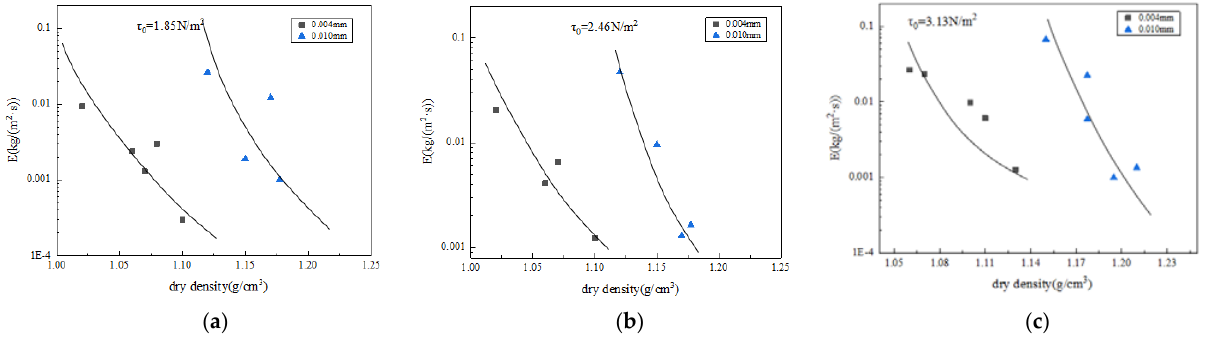
Figure 12. The relationship between dry density and scouring rate. ( a ) Shear stress = 1.85 N/m 2 ,